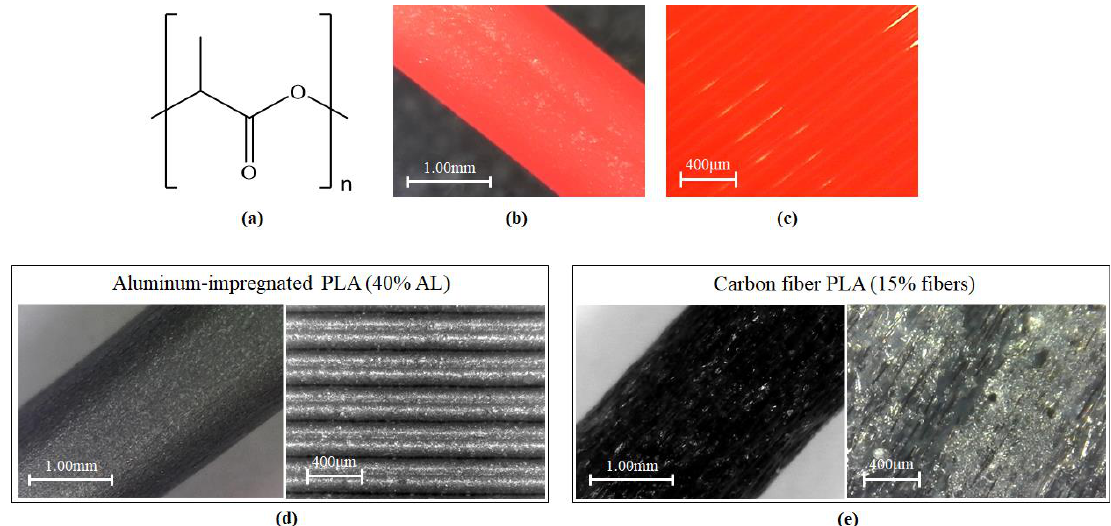
Figure 8. PLA ( a ) chemical structure; ( b ) raw material; and ( c ) final processed material; Aluminum-powder PLA ( d ) and carbon-fiber PLA ( e ) were special cases which were examined.